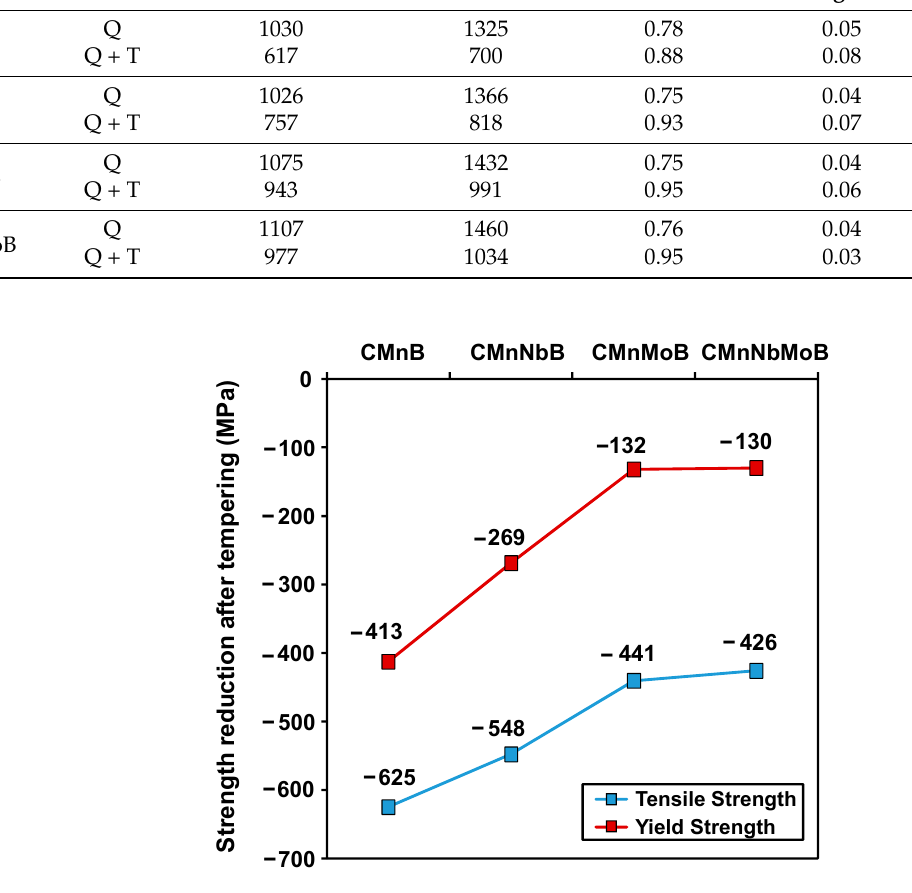
Figure 11. Reduction of yield strength and tensile strength after tempering treatment. Table 3. Tensile properties measured before and after tempering treatment for all the chemistries (YTR: yield-to-tensile ratio).